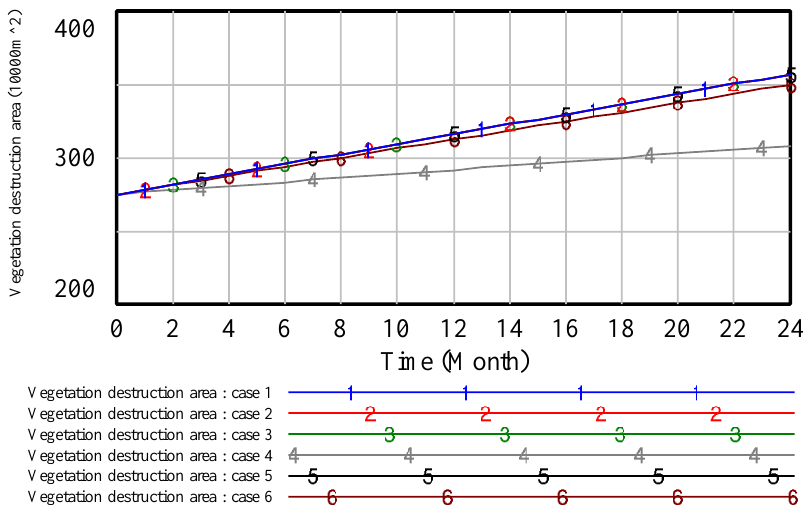
Figure 11. The simulation result of total vegetation destruction area.